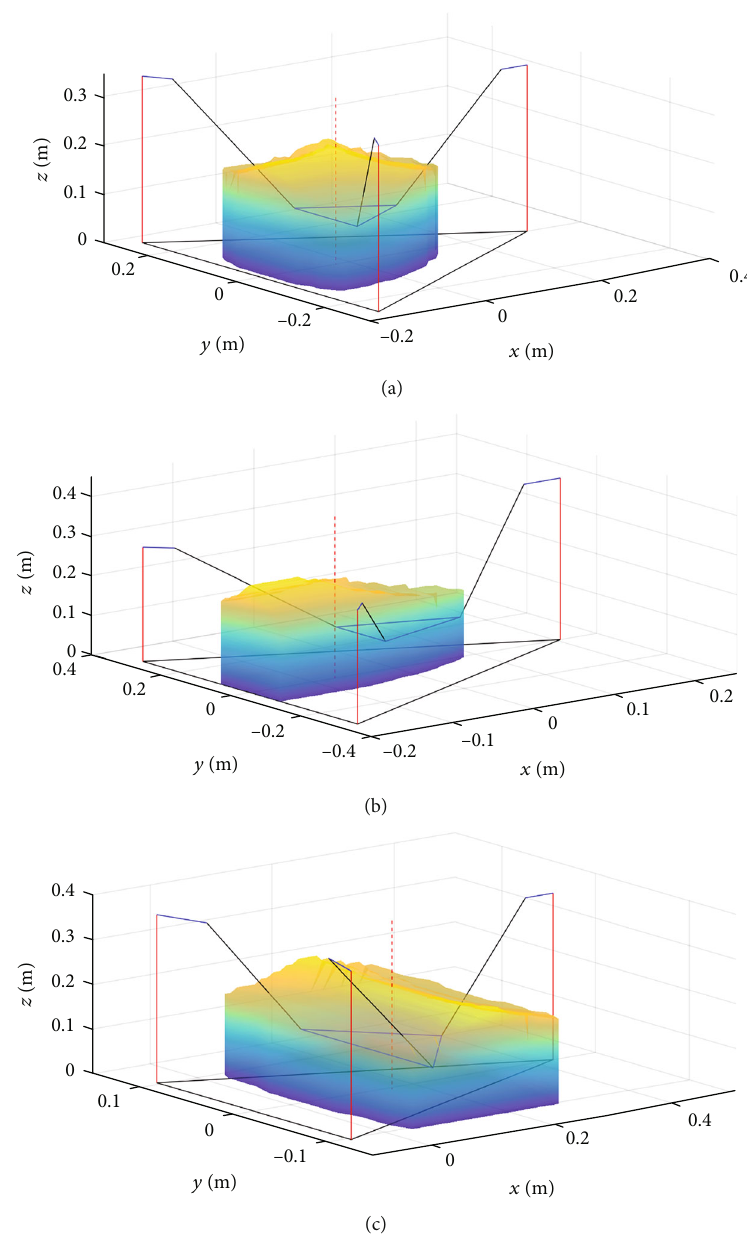
Figure 4: The workspace in di ff erent con fi